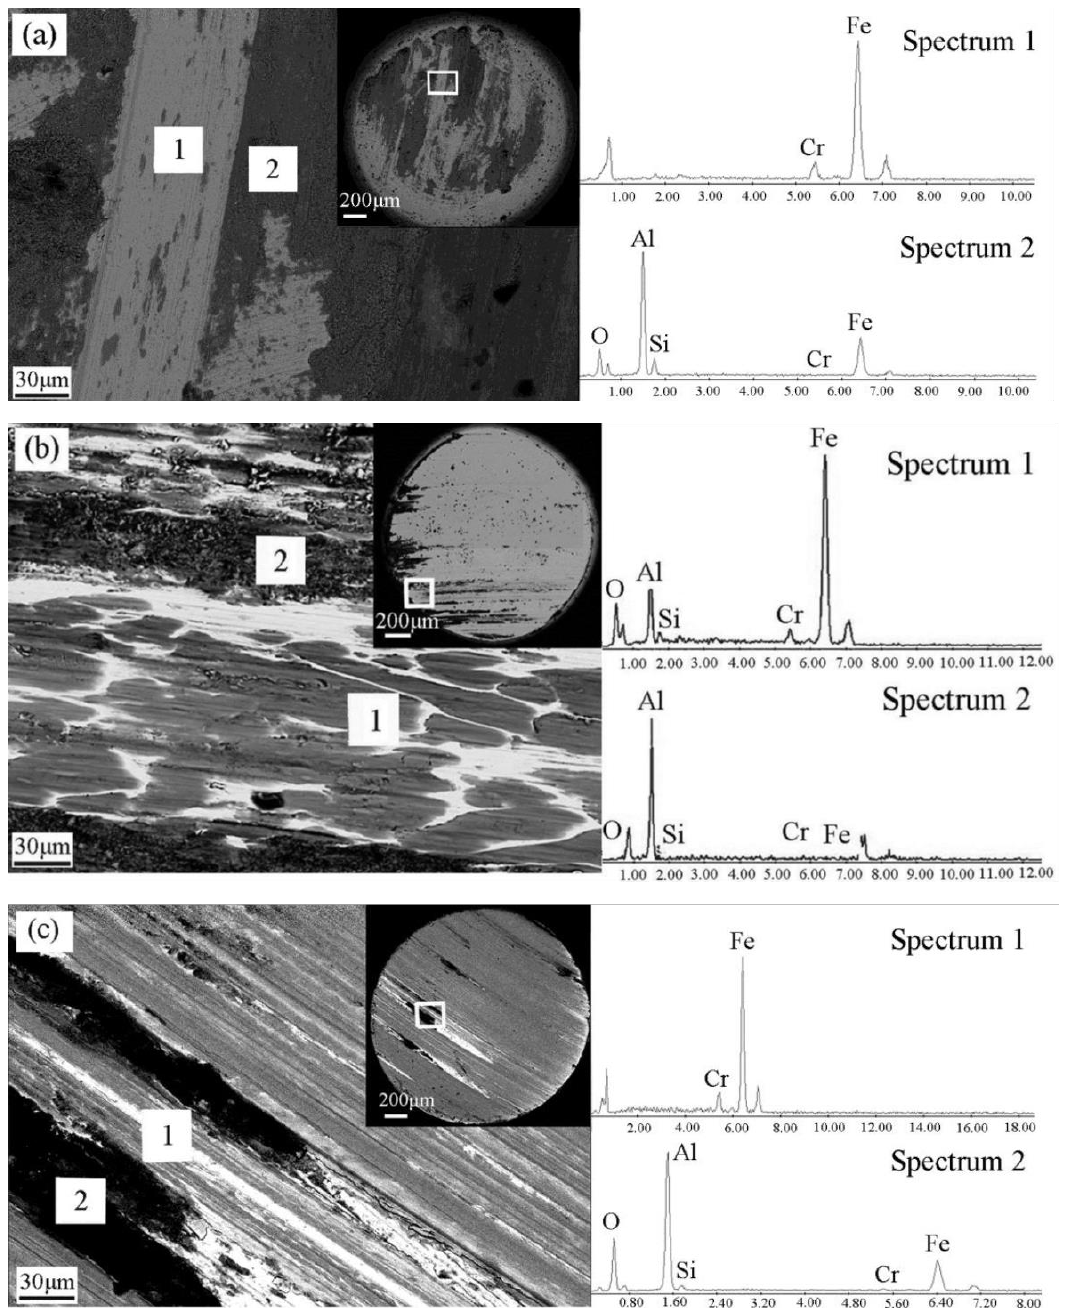
Figure 7. SEM images and energy-dispersive x-ray (EDX) analysis of the pin surfaces after 200 cycles when tested at: ( a ) 700 °C, ( b ) 800 °C [24], and ( c ) 900 °C.